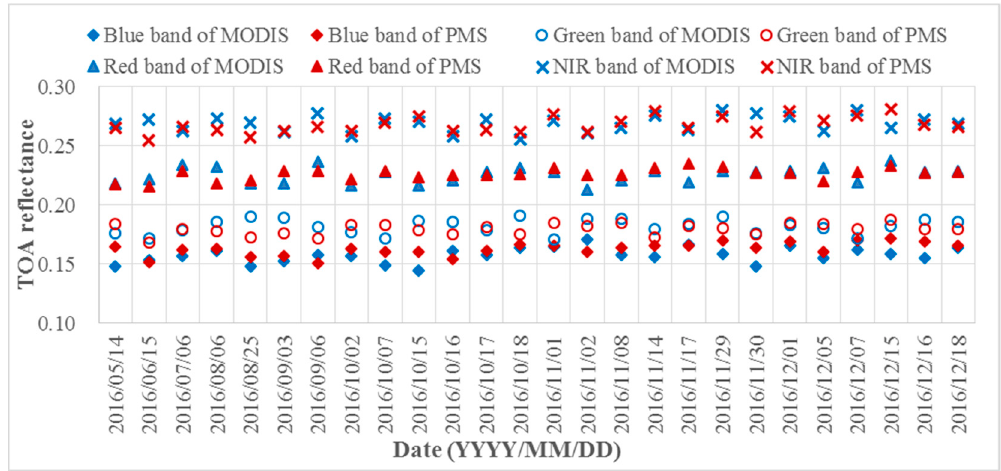
Figure 6. Comparison of the TOA reflectance between GF-4/PMS after cross-calibration and Terra/MODIS.